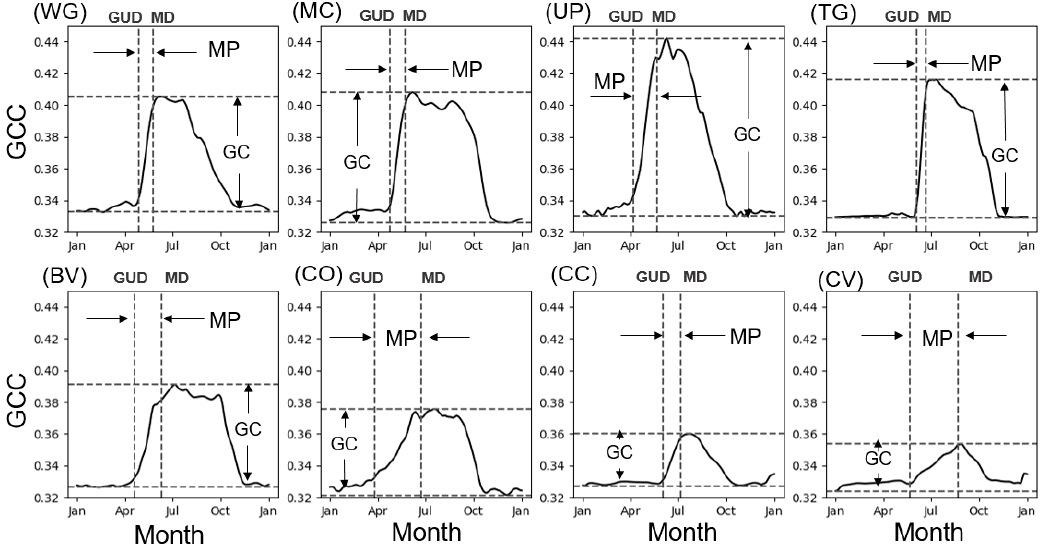
Figure 3. Green chromatic coordinate ( GCC ) curves of eight vegetation sites derived from PhenoCam data. The vegetation type at each site (identification (ID) in parentheses) is listed in Table 1. Table 1. Details of the eight sites where data were gathered for GC C curves used for the simulation. The abbreviations of vegetation types are switchgrass (SG), miscanthus (MC), grassland (GR), deciduous needleleaf (DN), deciduous broadleaf (DB), mixed vegetation (MX), shrubs (SH), and tundra (TN).